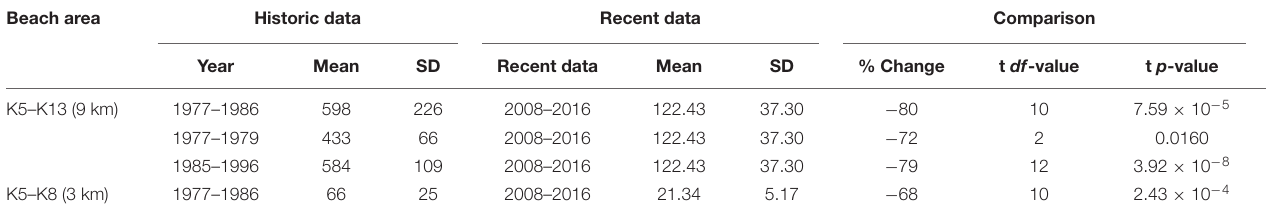
TABLE 5 | Results of comparisons made between historical and recent nest survey counts for percentage change and tests for significant difference (alpha = 0.05). Beach